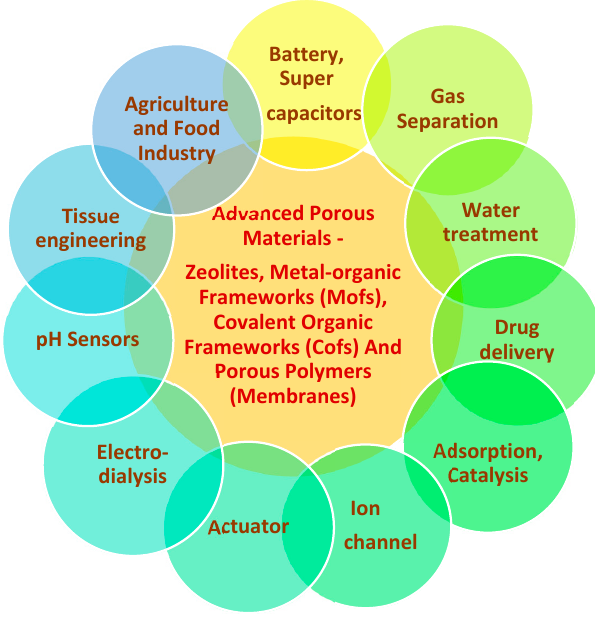
Figure 2. Advanced porous materials in various applications.